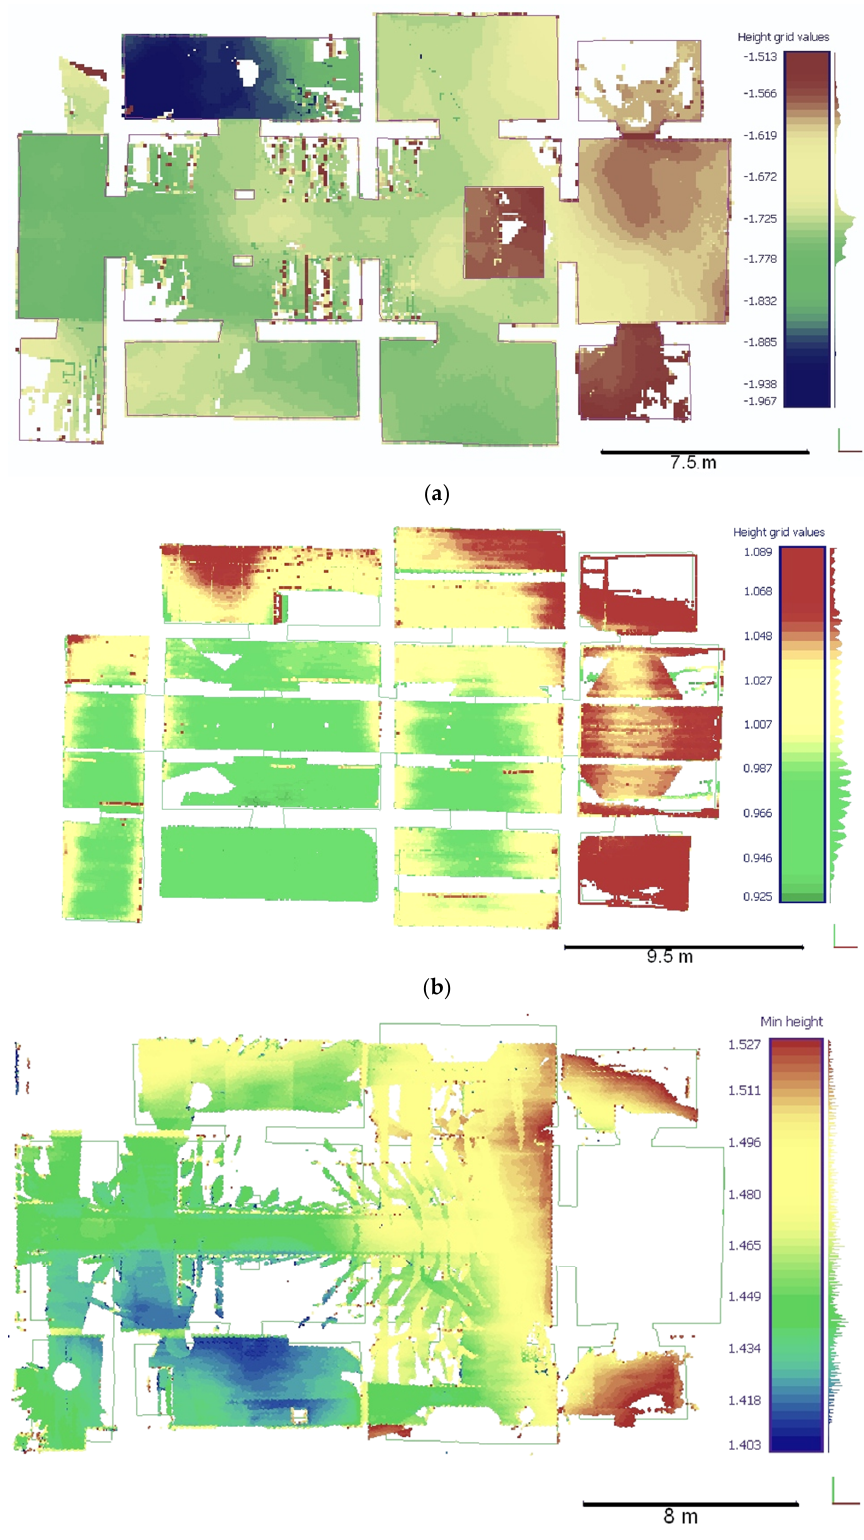
Figure 9. Relative changes (m) in floor height ( a )—the underground chapel, ( b )—its ceiling, and ( c )—the floor of the